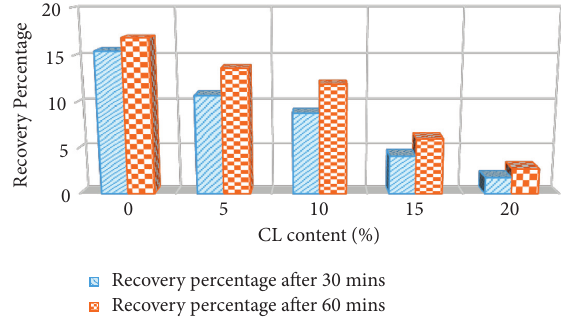
Figure 13: The elastic recovery test